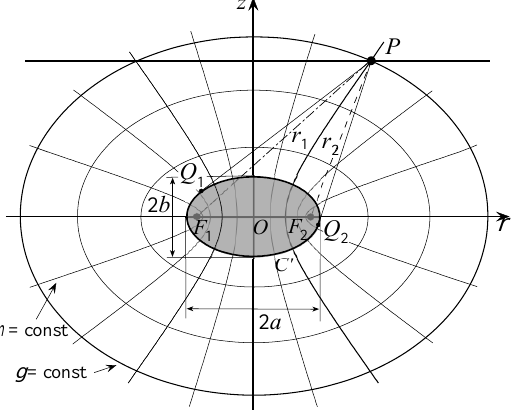
Figure A1. Relevant to the oblate spheroidal modelling.